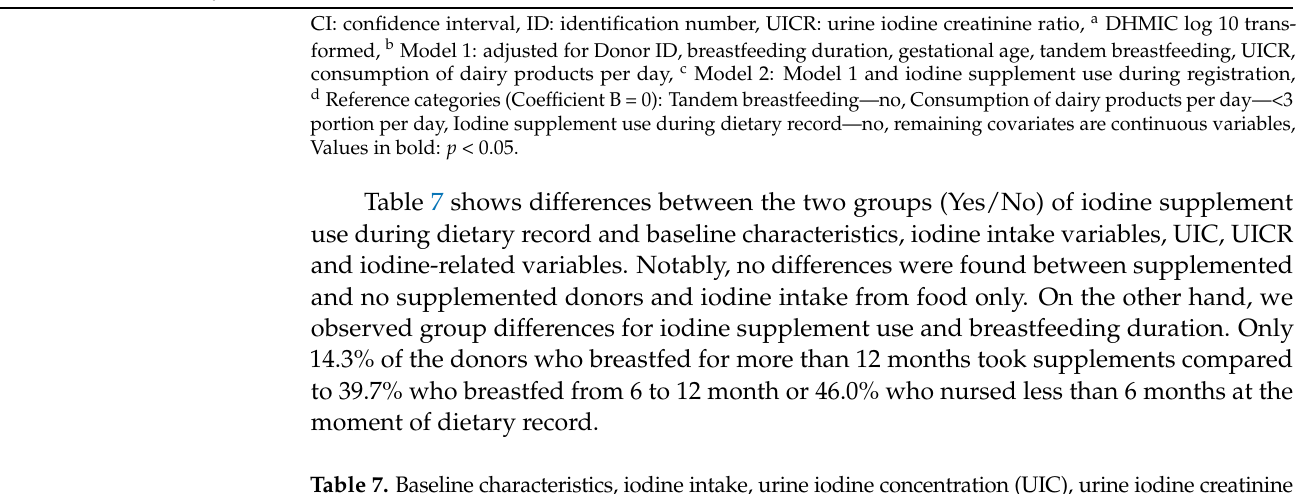
Table 7. Baseline characteristics, iodine intake, urine iodine concentration (UIC), urine iodine creatinine ratio (UICR) and iodine-related variables according to iodine supplement use during dietary